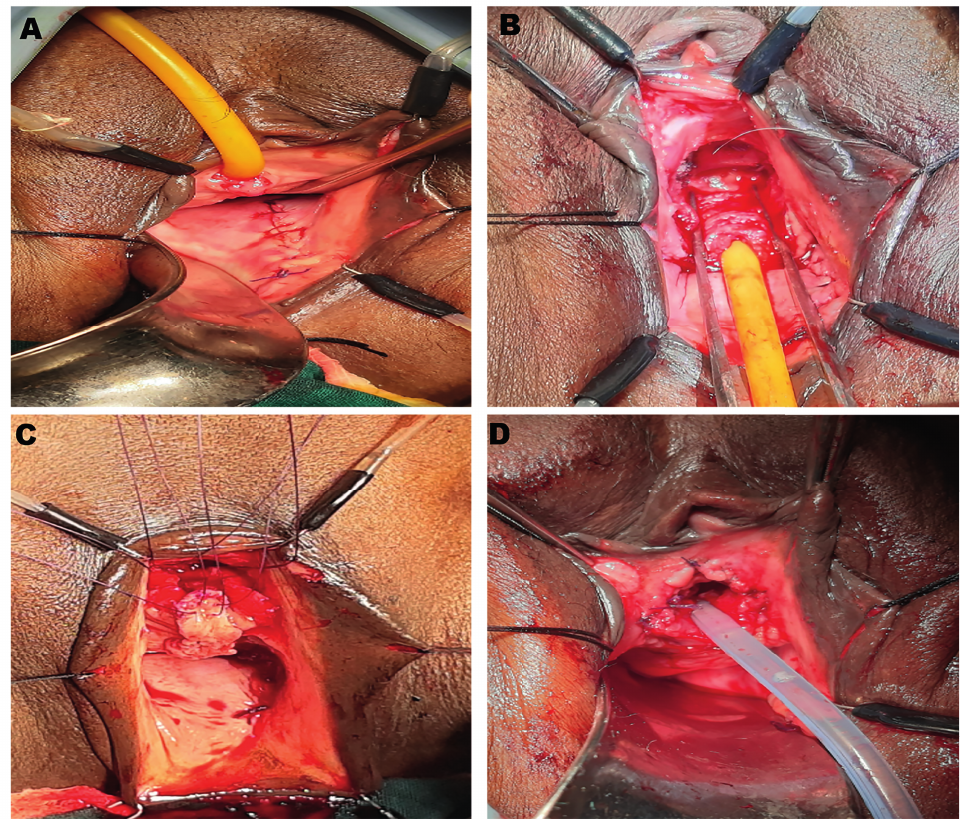
Figure 2 - Surgical steps in dorsal onlay graft urethroplasty. 2A- Harvesting of vaginal graft from posterior lateral vaginal wall and closure of harvest site. 2B-Dorsal dissection of urethra from clitoral bed up to the bladder neck after detachment of pubourethral ligament. 2C- Dorsal urethrotomy extending well beyond the stricture and preplaced sutures taken through apex of the laid open urethra and the vaginal graft. 2D- Finally constructed